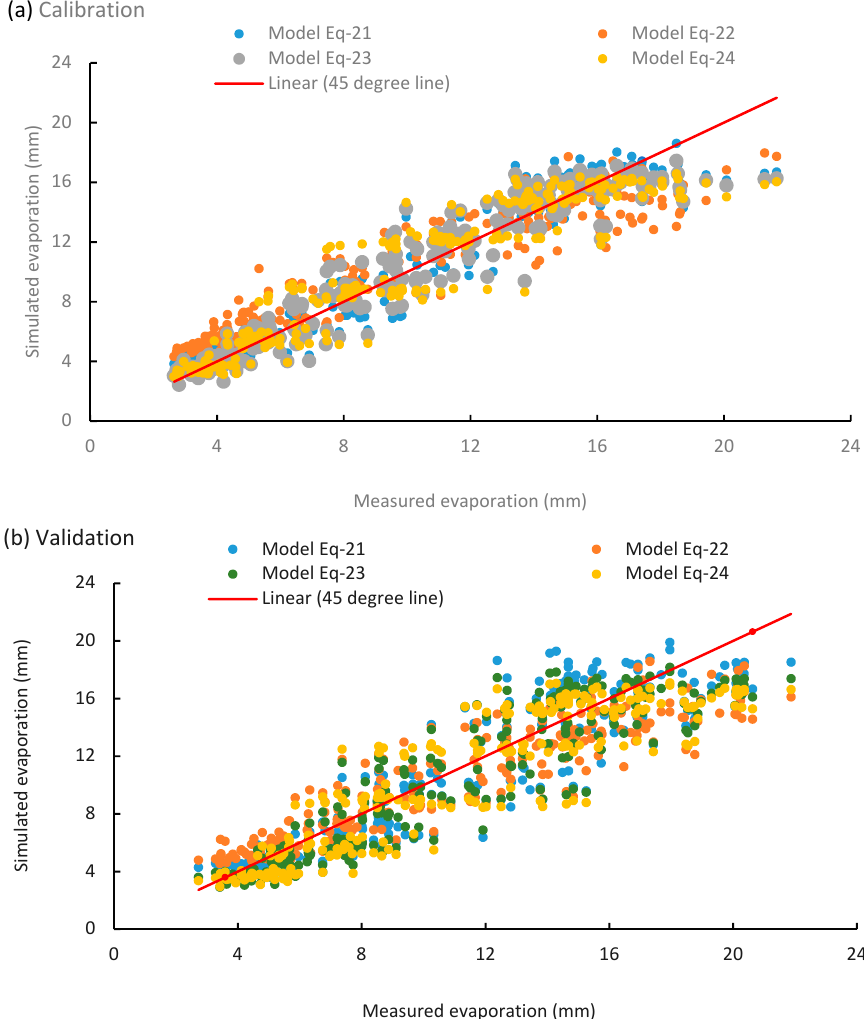
Figure 7. Comparison of the observed and simulated values of evaporation obtained from the four developed equations: ( a ) Calibration; and ( b ) Validation.